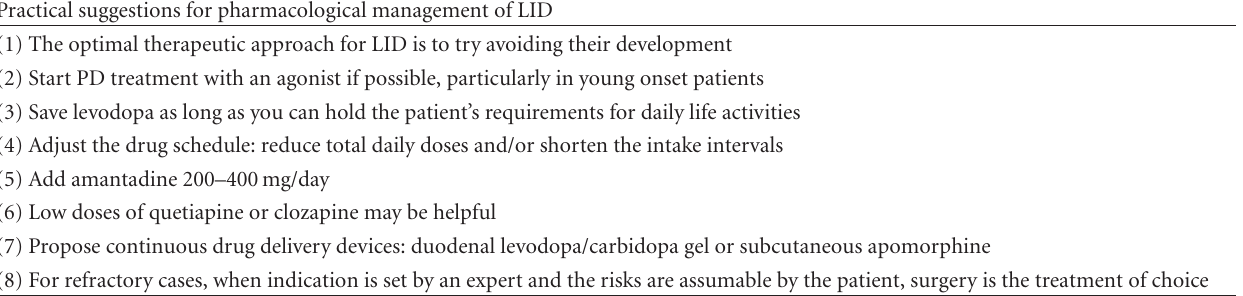
Practical suggestions for pharmacological management of